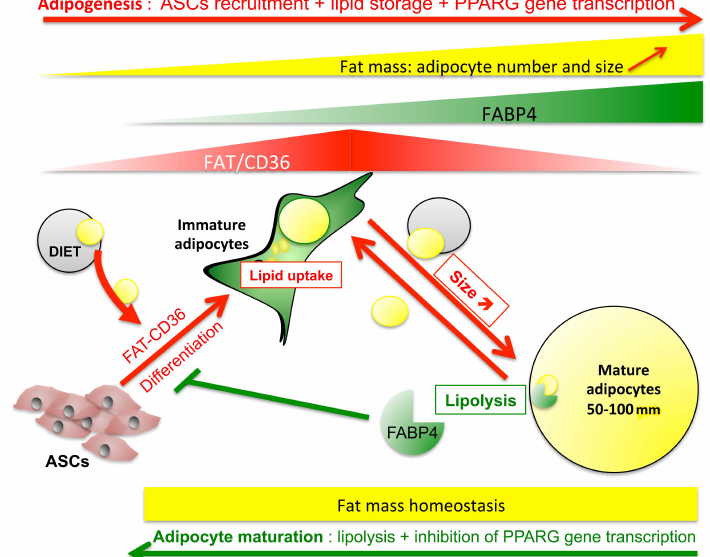
Figure 9. Putative mechanism of Fatty acid binding protein 4 (FABP4) role in the regulation of fat mass. Fat mass regulation proceeds through pro-adipogenic processes allowing lipid storage (red pathways) requiring fatty acid-induced PPARG gene transcription, lipid uptake, and inhibition of lipolysis. Fatty acid interaction with FAT/CD36 controls both AMPK anti-lipolytic activity and PPARG mediated gene transcription, including those of FAT/CD36 and FABP4 . FAT/CD36 increases during adipogenesis together with FABP4. Increased accumulation of FABP4 in absence of lipolysis in mature adipocytes is a limiting factor inducing reduction of FAT/CD36 through PPARG inhibition (negative feedback), which in turn alters its antilipolytic activity. Finally, FABP4 exerts a limitation to a fatty acid-induced increase of adipocyte size through the restoration of basal lipolysis (green pathways), then promotes small or immature adipocytes to reach the optimal size but inhibits the recruitment of new adipocytes. The model suggests that under normal conditions, lipid storage is then optimized to obtain a homogenous population of adipocytes (in a range of 50–100 µ m) allowing to monitor the metabolic response to diet uptake versus energy